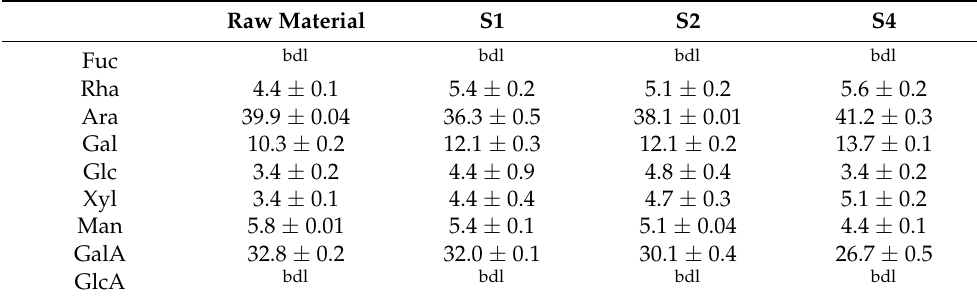
Table 5. Monosaccharide composition (mol%) of soluble dietary fiber (SDF) of enzymatically treated apple pomace (raw and extruded) after methanolysis (mean value ± range/2, n = 2) Fuc: fucose, Rha: rhamnose, Ara: arabinose, Gal: galactose, Glc: glucose, Xyl: xylose, Man: mannose, GalA: galacturonic acid, GlcA: glucuronic acid, S1: only transport elements, S2: two reverse elements, S4: two reverse elements and a kneading block, bdl: below detection limit. Raw Material